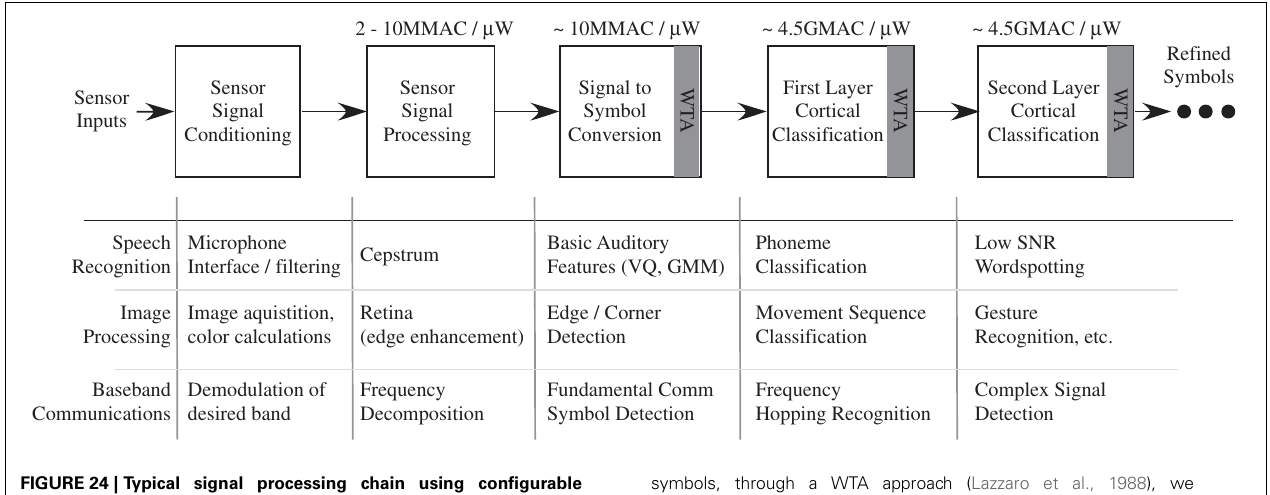
FIGURE 24 | Typical signal processing chain using configurable analog approaches and neural based classifiers. Once the input signal becomes established as a refined probability of low-level